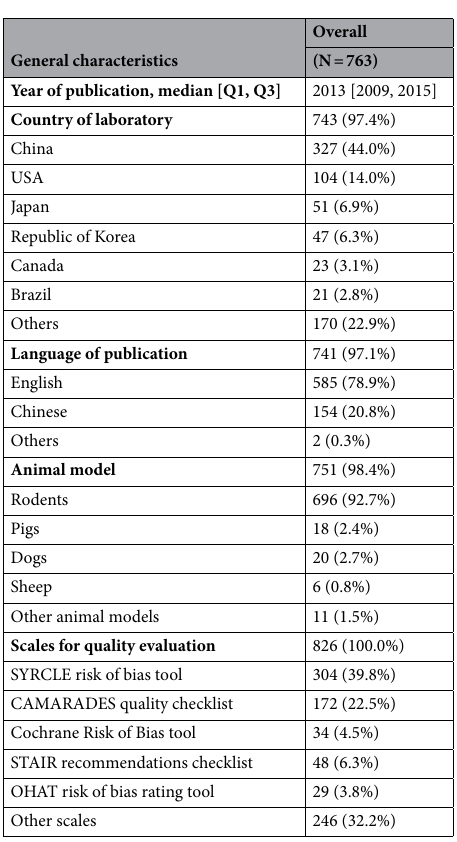
Table 4. General characteristics of the included studies in